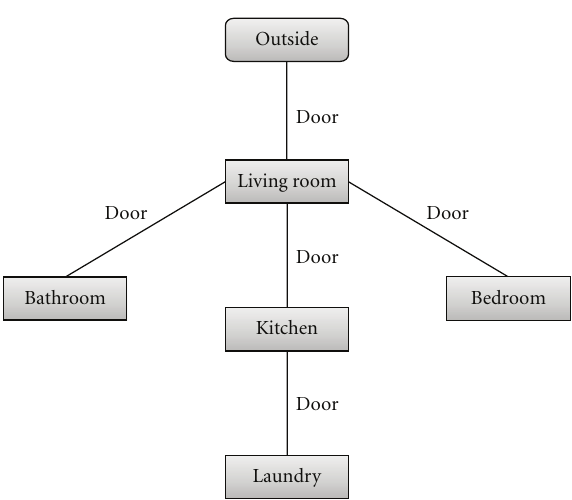
Figure 7: Connectivity graph for a generated floor plan.